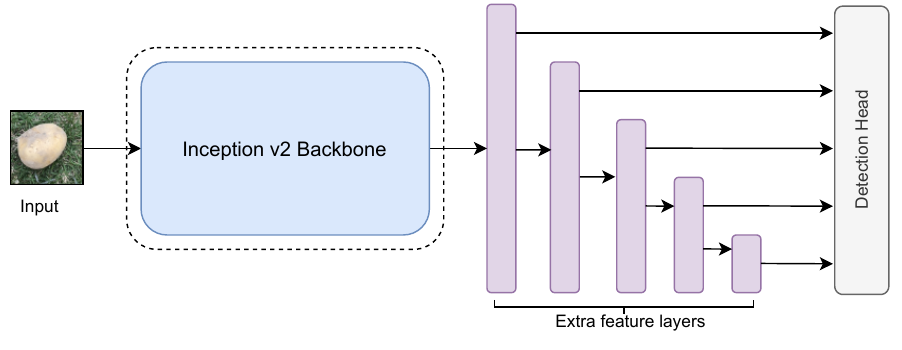
Figure 5. The SSD Inception V2 model.